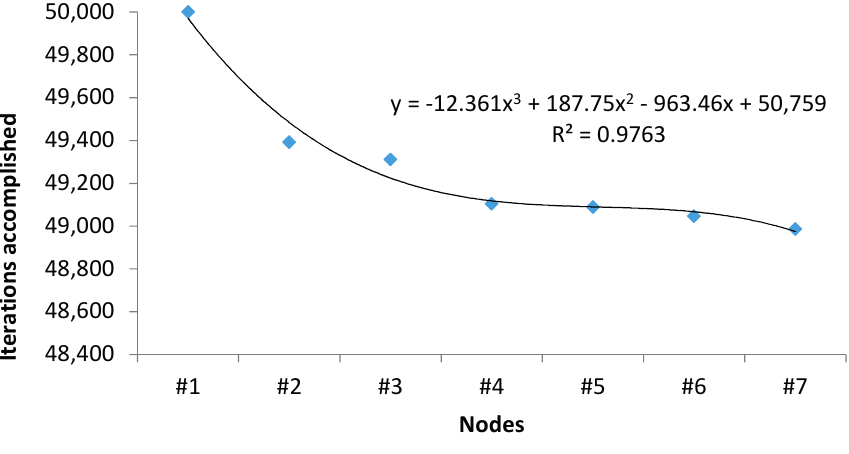
Figure 18. Iterations accomplished by nodes.